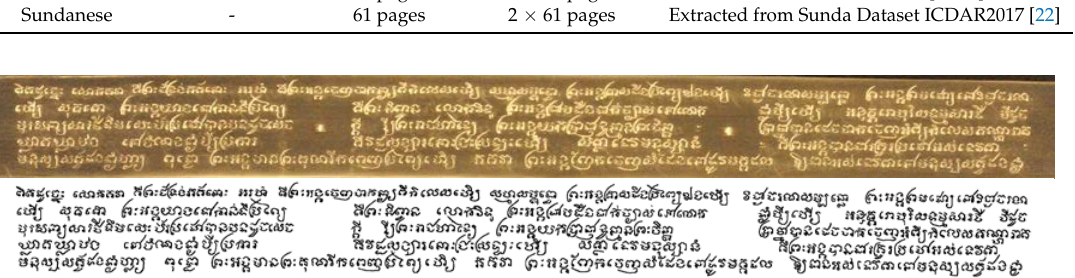
Figure 11. Khmer manuscript with binarized ground truth image.